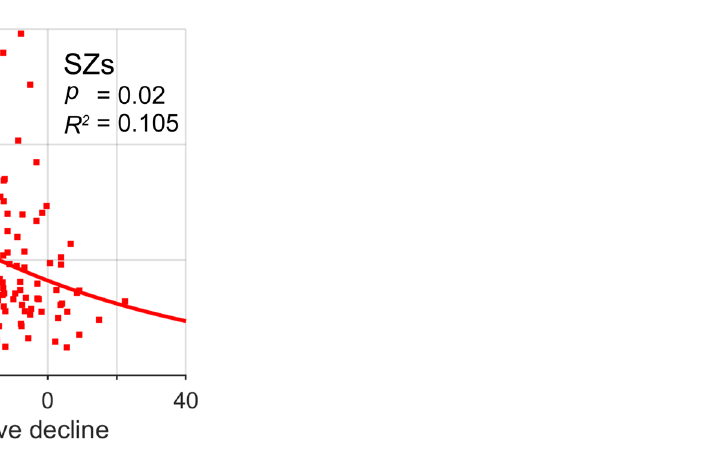
Figure 6. Relationship between return saccade probability and cognitive decline for SZs. Line represents the regression line estimated by the GLM model. Bonferroni-corrected p values and adjusted R 2 are